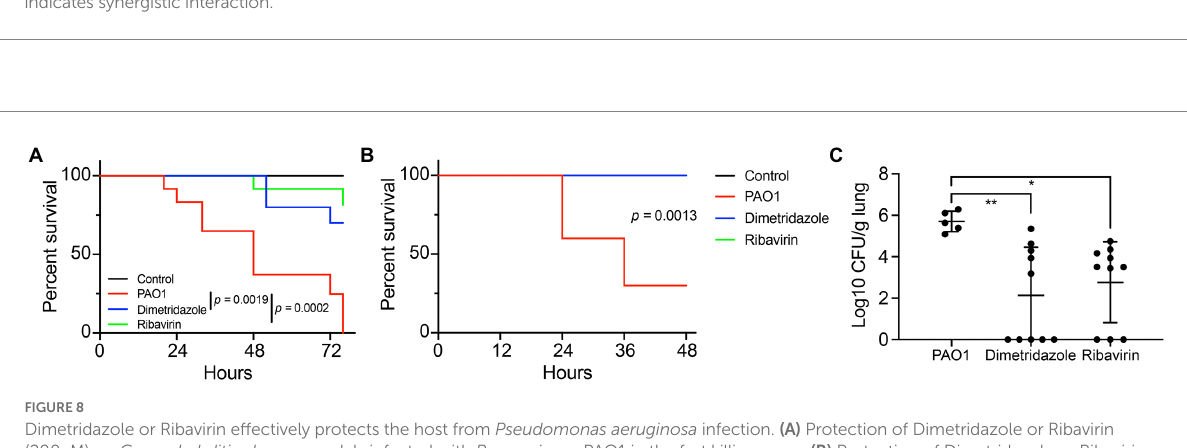
FIGURE 7 Synergic interactions of Dimetridazole and Ribavirin with antibiotics. Cell densities of Pseudomonas aeruginosa clinical isolates (A) SIIA-4, (B) SIIA- 9, and (C) SIIA-11 cultured in MH broth supplemented with Dimetridazole or Ribavirin and polymyxin B, meropenem, or kanamycin at different combinations. Influences of different combinations of Dimetridazole or Ribavirin and polymyxin B, meropenem, or kanamycin on the growth of (D) SIIA-4, (E) SIIA-9, and (F) SIIA-11 as calculated by the Bliss independence mode. Tiffany blue color indicates antagonistic interaction. Red color indicates synergistic interaction.